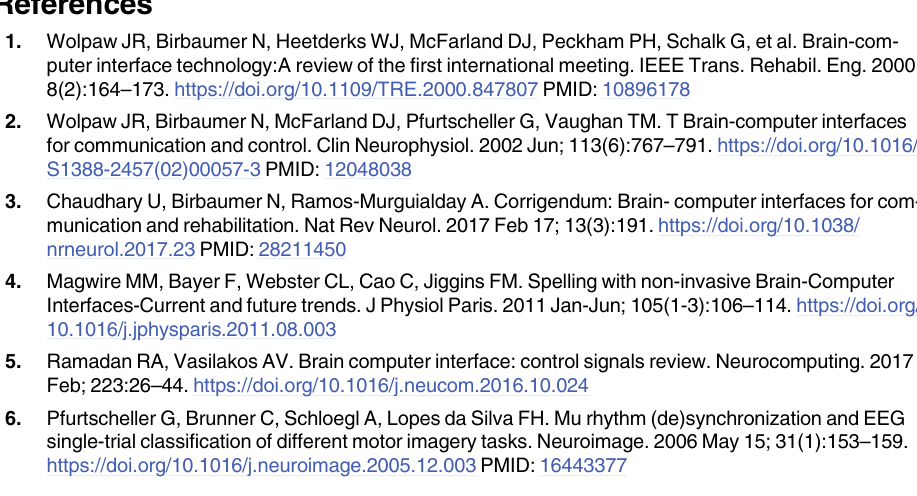
S9 Table. Data for drawing Fig 12. The data of the trained weights computed by three RVM kernel functions. S10 Table. Data for drawing Fig 13. The detailed data for explain the influence of the parame- ter beta, in the chaos kernel, on the classification